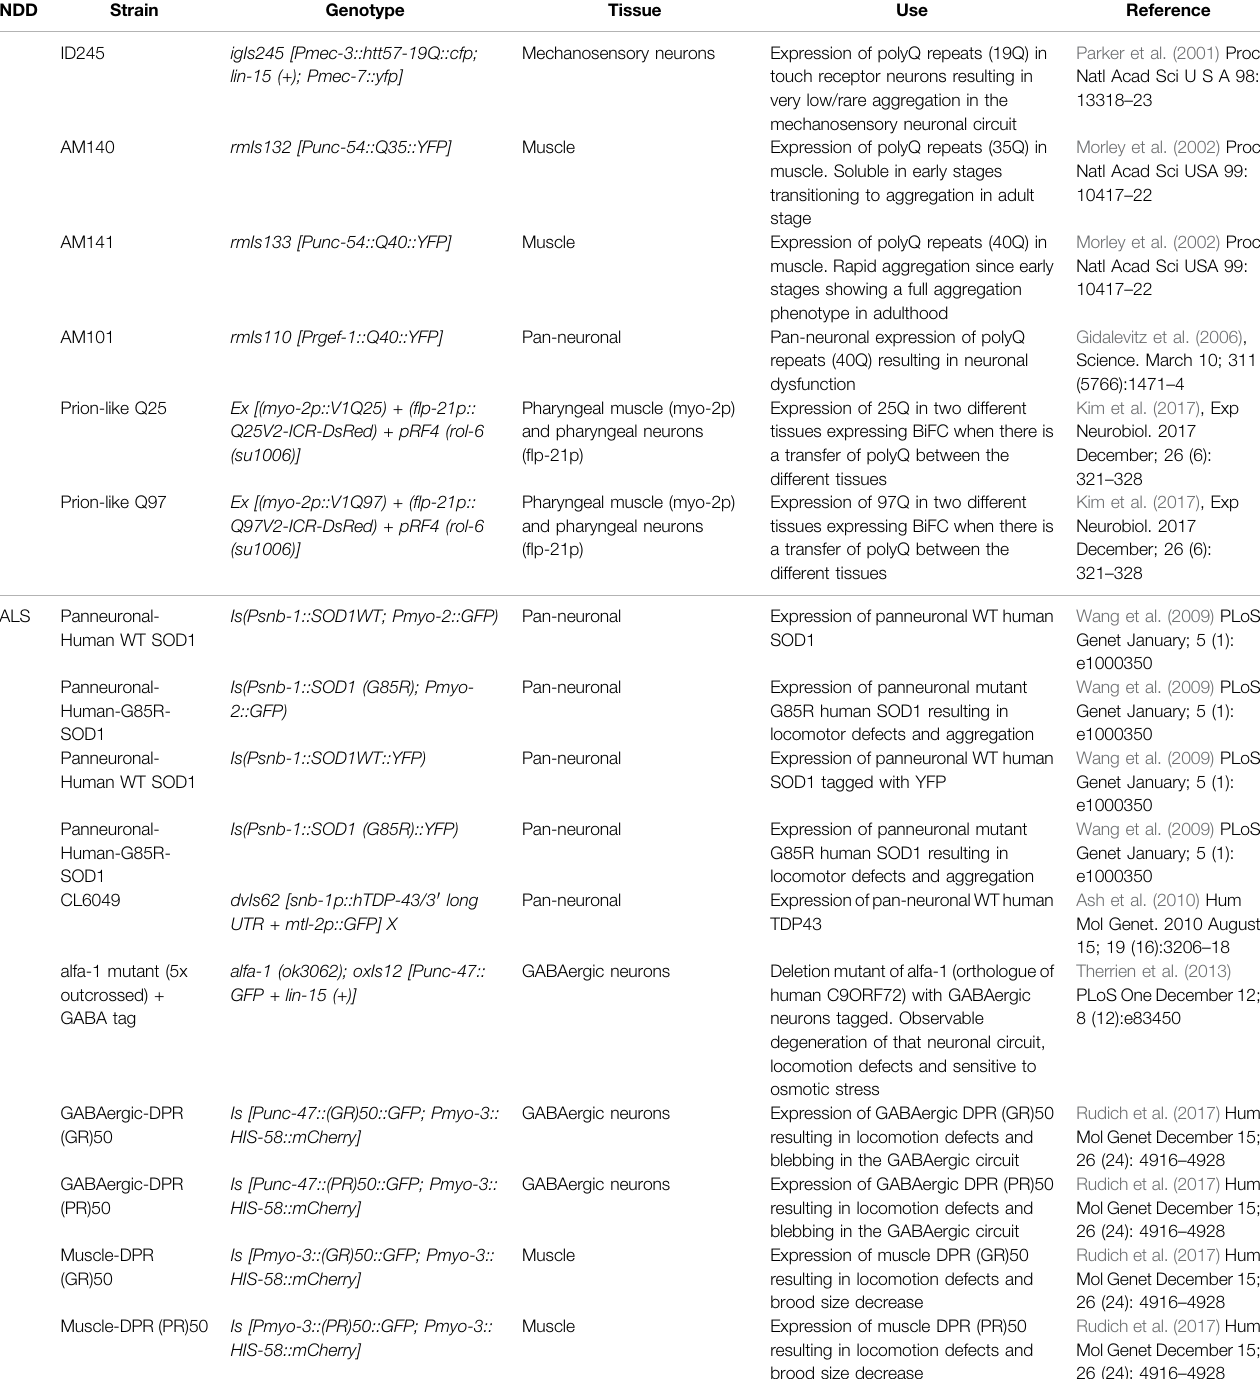
TABLE 1 | ( Continued ) C. elegans strains used to model neurodegenerative